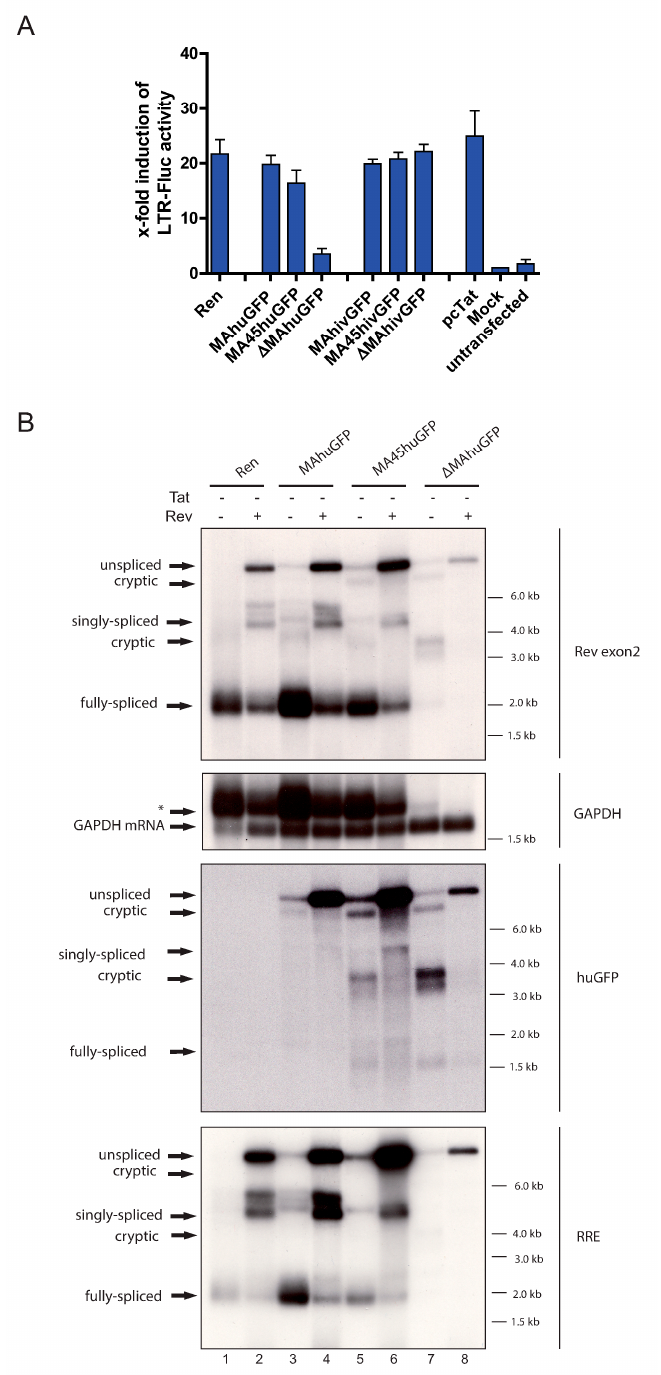
Figure 3. The insertion of huGFP decreased Tat-mediated LTR activity. ( A ) LTR promoter-driven expression of Firefly luciferase was measured after co-transfection of the indicated proviral constructs and was normalized to CMV-Renilla luciferase expression, which served as the transfection control. All experiments were done in the absence of Rev. n = 4. Error bars represent SD. ( B ) Northern blot of total RNA from HEK 293T cells transfected with the indicated proviral constructs in the absence of Tat. Membranes were rehybridized with different probes specific for Rev exon 2, huGFP, RRE, and GAPDH, which served as the loading control. The different splice variants are indicated on the left, sizes are given on the right, and residual signal from the previous hybridization is marked by an